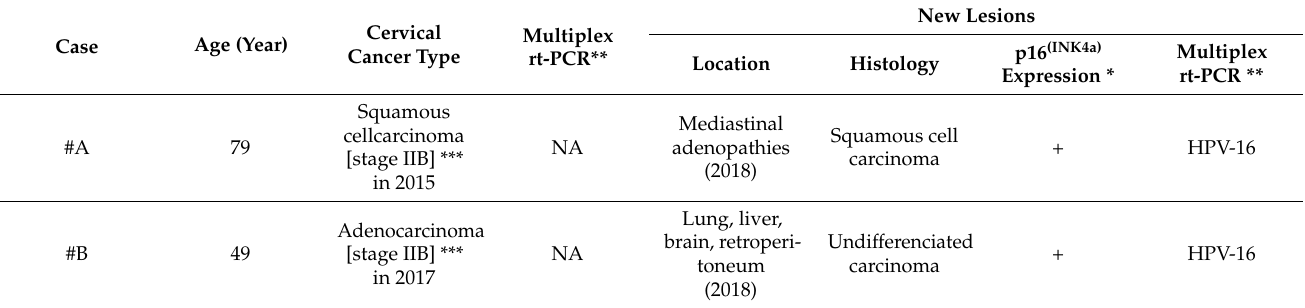
Table 1. Clinical and pathologic findings in patient cases of cervical cancer and possible metastatic